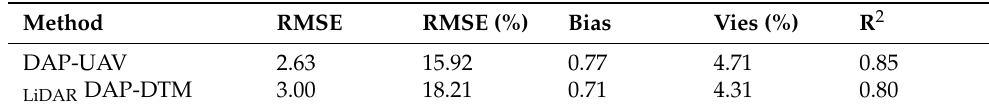
Table 6. Statistics of the comparison between the H max metric obtained by DAP-UAV and DAP- DTM LiDAR and the maximum heights of the plots obtained by the TFI.